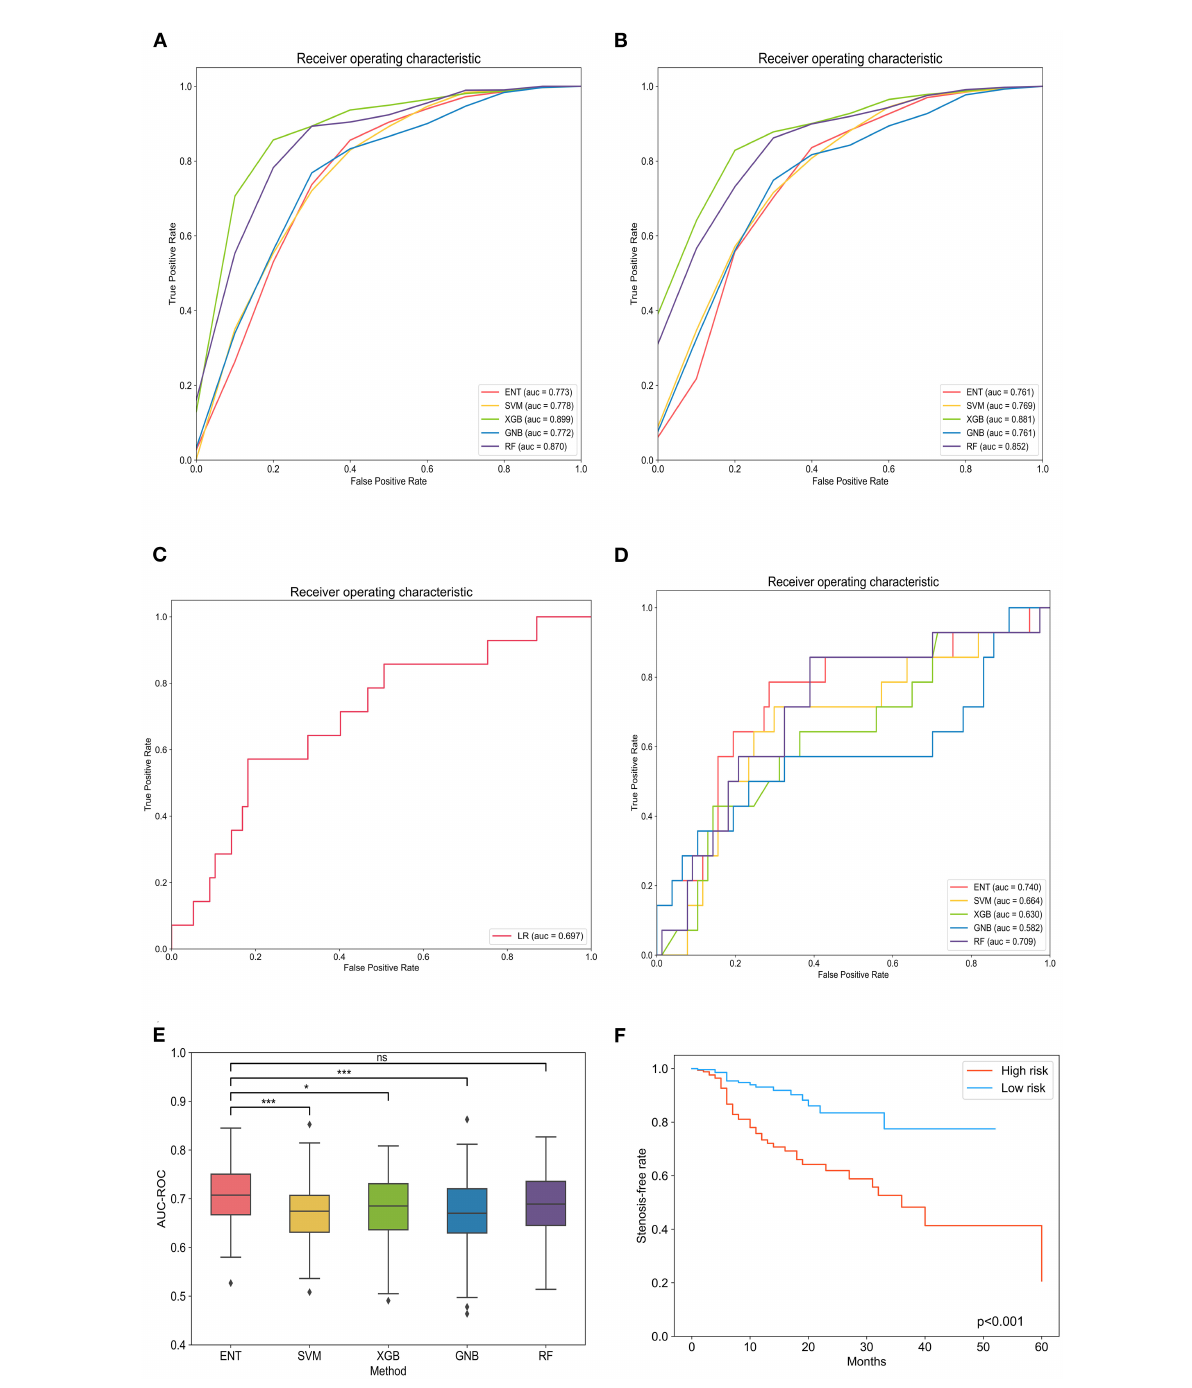
FIGURE2 Evaluation of machine learning model performance in the training, validation, and test sets. (A) Comparison of the area under the receiver operating curve of different models in the training set. (B) Comparison of the area under the receiver operating curve of different models in the validation set. (C) Comparison of the area under the receiver operating curve of different models in the test set. (D) The receiver operating curve of logistics regression. (E) Box plot of model area under the receiver operating curves in each loop. *Tukey honestly significant difference (HSD) test p < 0.05 between the models; *** Tukey HSD test p < 0.005 between the models; ns Tukey HSD test p > 0.05 between the models. (F) Kaplan–Meier curves of in-stent stenosis rates for high-risk patients (predicted value > optimal threshold) and low-risk patients (predicted value < optimal threshold). ENT, elastic net; SVM, support vector machine; XGB, Xgboost; GNB, Gaussian Naïve Bayes; RF, random forest; LR, logistics